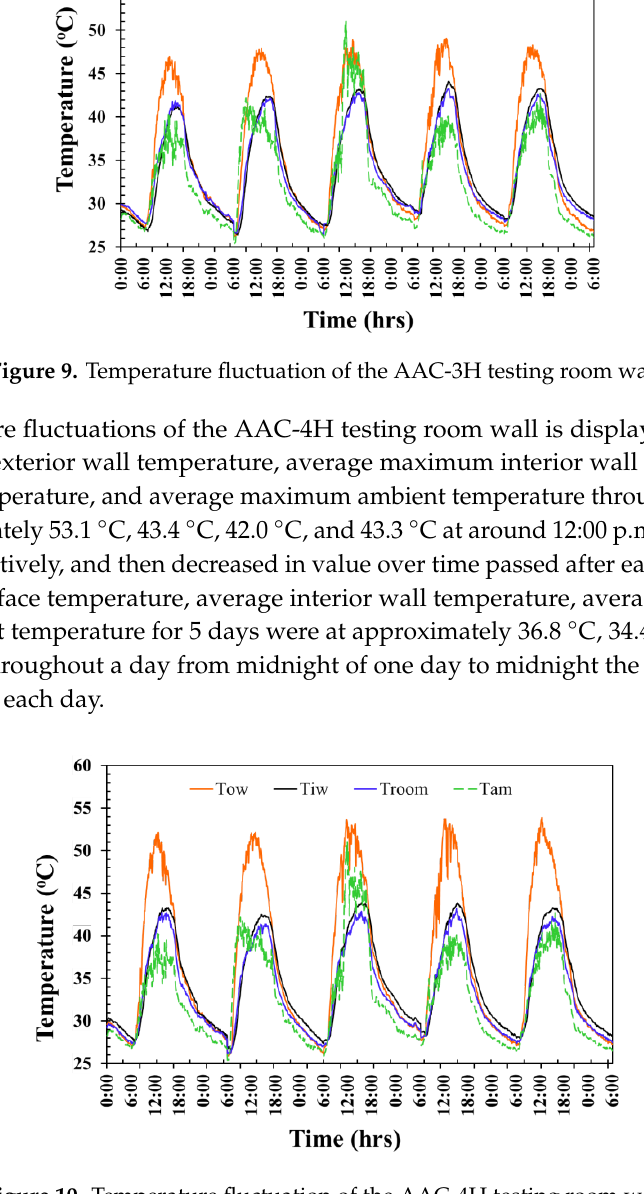
Figure 10. Temperature fluctuation of the AAC-4H testing room wall.